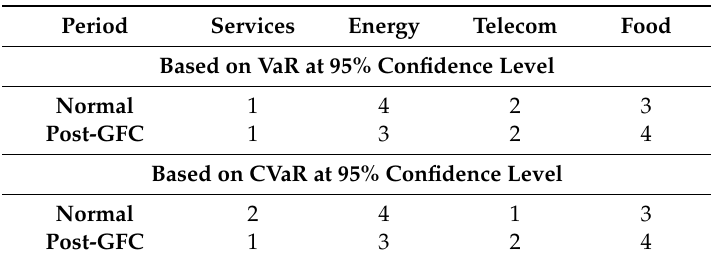
Table 6. Sub-sample ranking of four key industries, 2009–2017. Period